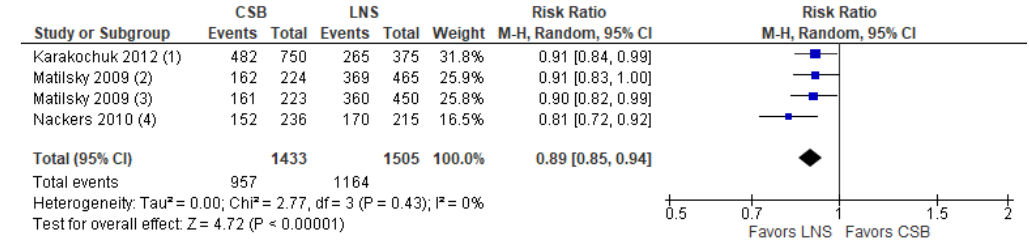
Figure 5. Forest plot of CSB compared to LNS—Outcome: Recovery rate (1) CSB vs Supplementary Plumpy/Nutriset; Recovery was defined as WFH ≥ 85% on 2 consecutive visits within 16 weeks; (2) CSB vs milk/peanut fortified spread; defined as having a WHZ > − 2 within 8 weeks; (3) CSB vs soy/peanut fortified spread; defined as having a WHZ > − 2 within 8 weeks; (4) CSB vs standard RUTF; Recovery defined as reaching a WHM% >/= 85% for 2 consecutive weeks within 16 weeks. Subgroup analysis by dose and duration did not lead to any changes in conclusions.